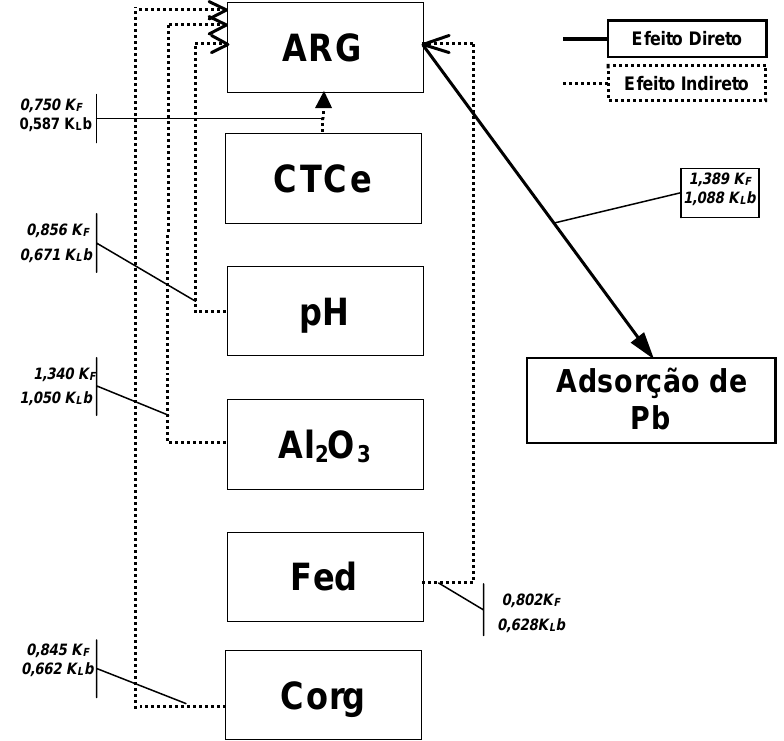
Figura 2. Diagrama explicativo com os valores dos efeitos diretos e indiretos obtidos da análise de trilha para as constantes Freundlich (K ) e capacidade-tampão máxima (K F CTCe, pH, ARG, Al O e Fed para amostras 2 3